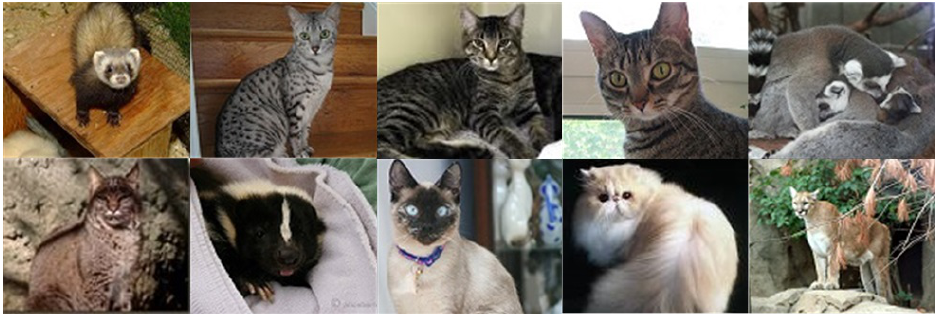
Figure 1. Ten different types of cats from